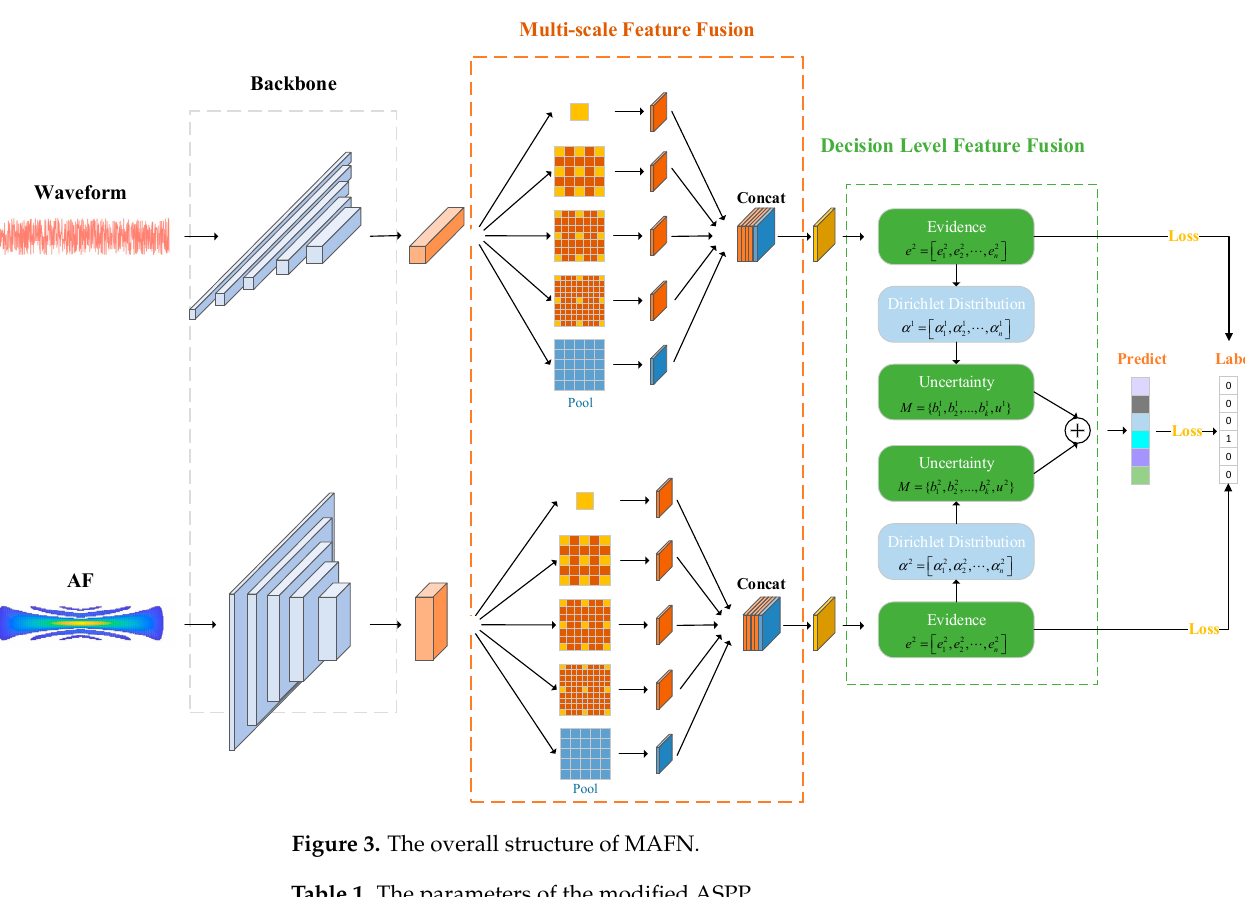
Table 1. The parameters of the modified ASPP.